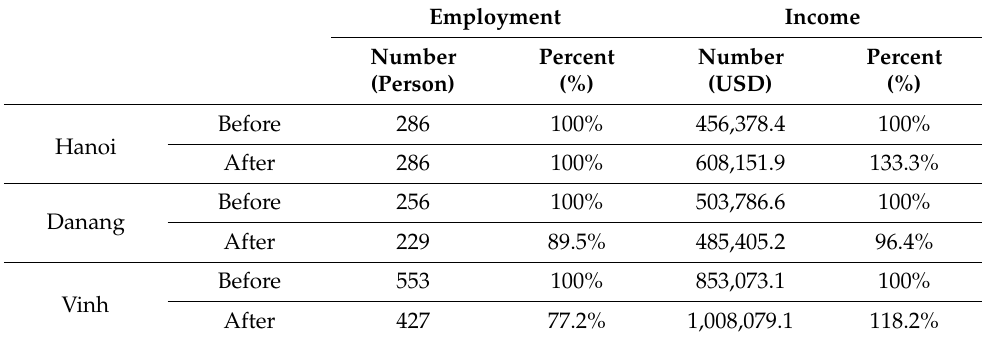
Table 4. Income and employment of all surveyed households before and after land